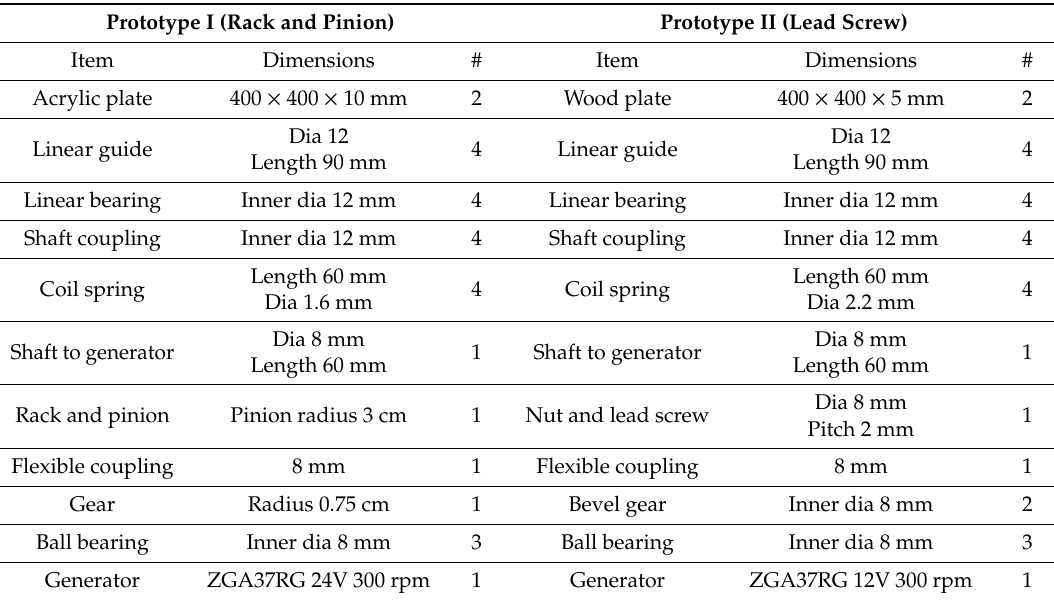
Figure 14. Photograph of Lead-Screw Prototype. Table 7. Components of rack and pinion and lead-screw prototypes.